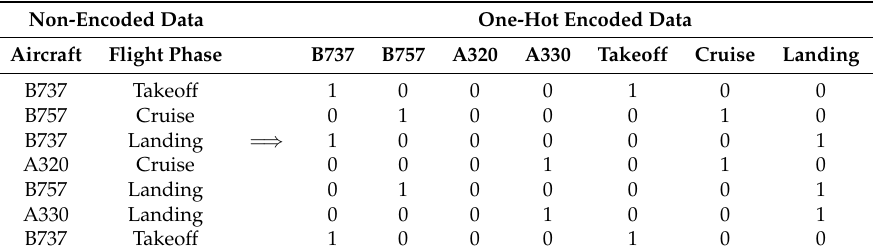
Table 2. Notional one-hot encoding procedure for two categorical